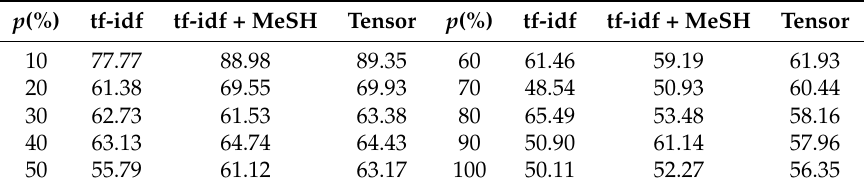
Table 5. Cosine similarity, k-means clustering and precision.